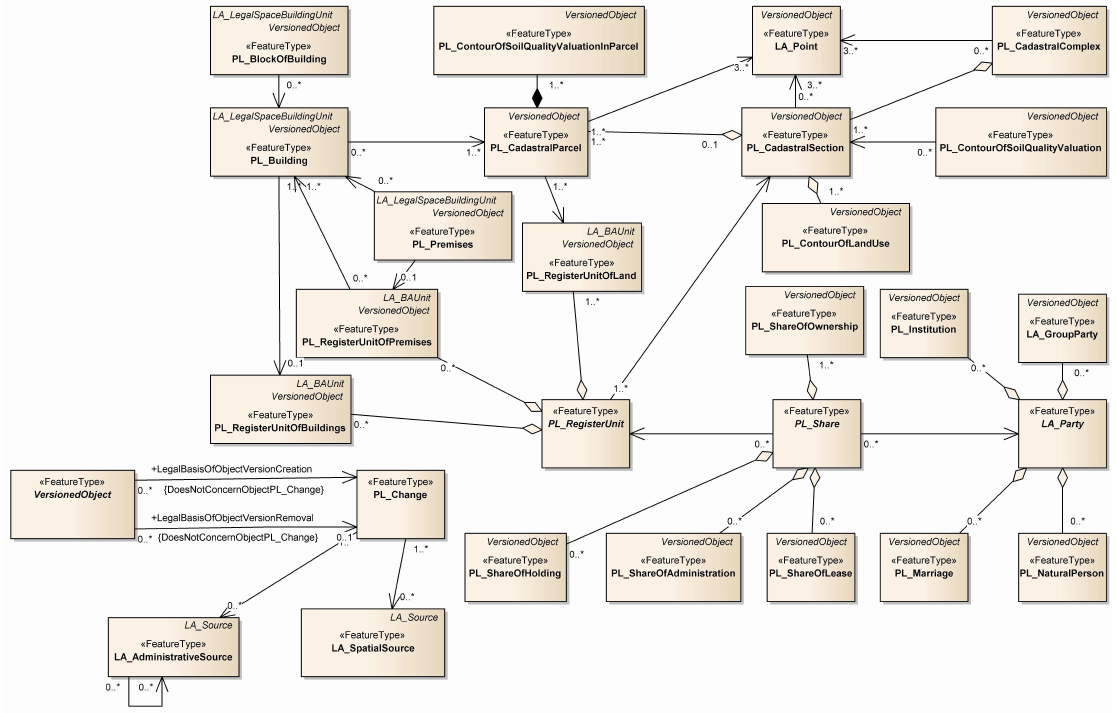
Figure 1. The profile of the Polish cadastre based on the Land Administration Domain Model